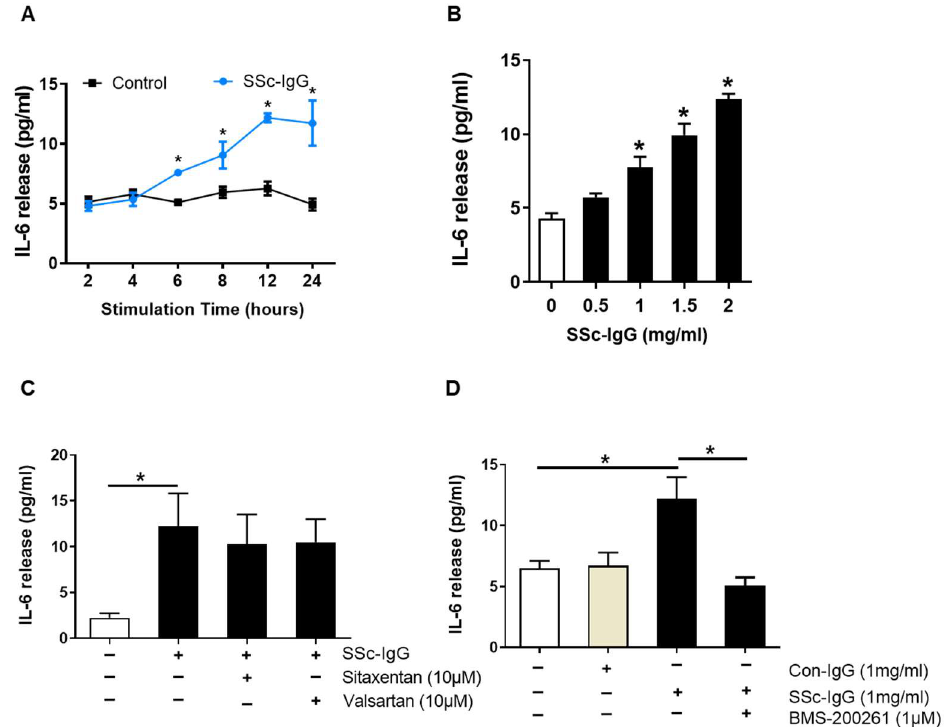
Figure 2. Effect of SSc-IgG on IL-6 production by human microvascular endothelial cells. HMECs were cultured in the presence or absence of SSc-IgG and assessed for ( A ) time- and ( B ) dose-dependent IL-6 secretion (n = 4). The exposure time in ( B ) was 24 h, while the dose of SSc-IgG in ( A ) was 1.0 mg/mL. In separate experiments, HMECs were pretreated for 1 h with ( C ) either valsartan (AT1-R inhibitor) or sitaxentan (ETA-R inhibitor) or ( D ) BMS-200261 (PAR-1 inhibitor) at doses indicated and then stimulated with SSc-IgG (1 mg/mL) for 24 h ( n = 5). To check for specificity of the effect of SSc-IgG, sister HMECs in D were treated with IgG from healthy controls (Con-IgG) at the same dose. For comparison, separate HMECs in D were treated with thrombin. ANOVA mean +/ − SEM with * p <